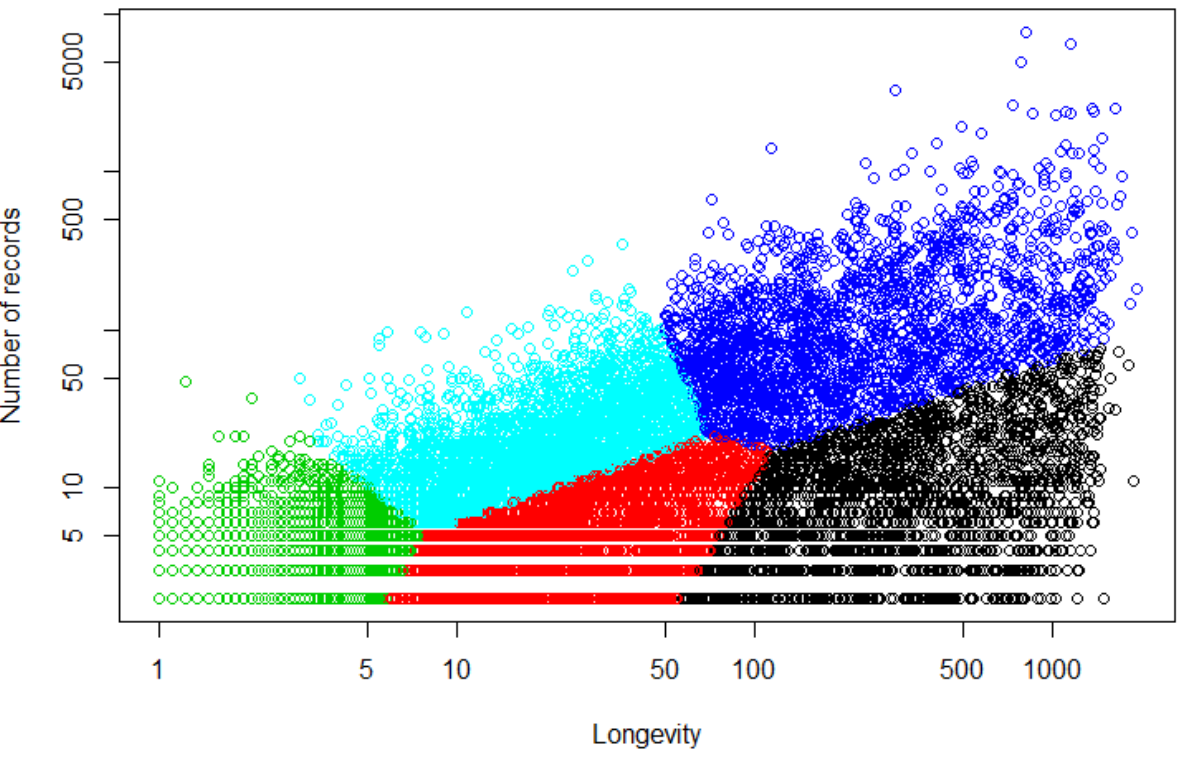
Figure 3. Clustering solution using 5 clusters where Blue is high longevity, high number of records; Black is high longevity, low number of records; Cyan is low longevity, high number of records; and Red and Green are low longevity, low number of